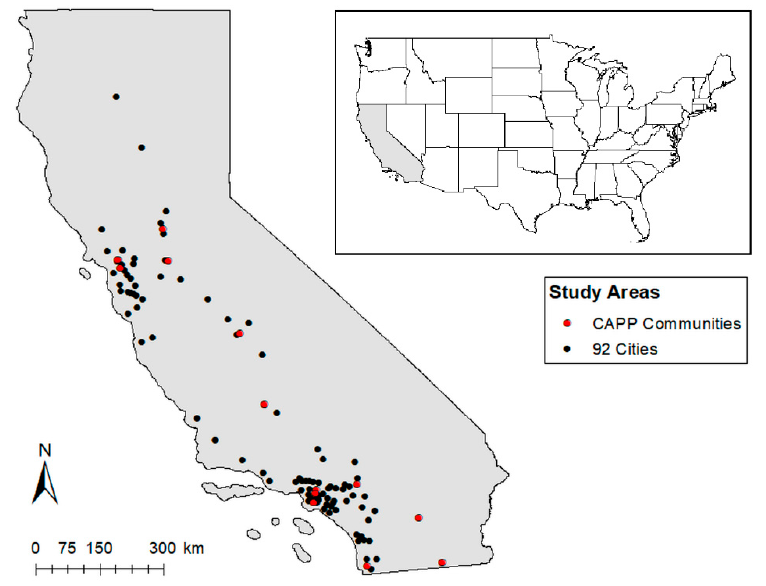
Figure 1. Map of California showing 13 CAPP communities (2020) and 92 cities included in the study analyses.